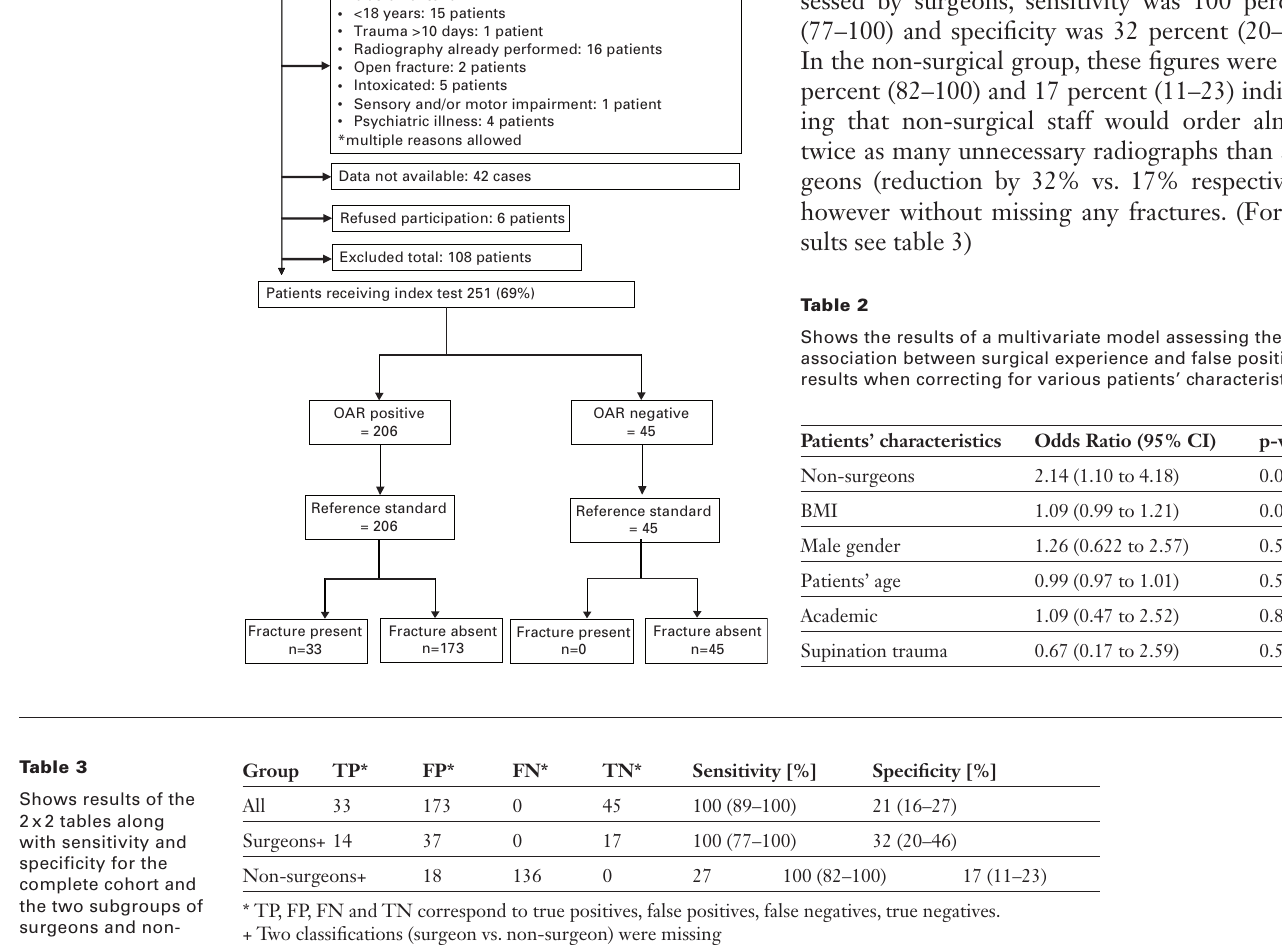
Figure 2 Receiver operating characteristics plot showing the results of 15 studies (circles) that assessed the ankle rule in a recent systematic review [2] with the results (and confidence intervals) of the current study (T). The box plots on the axes indicate that the results of the cur- rent study lie well within the range of the previous